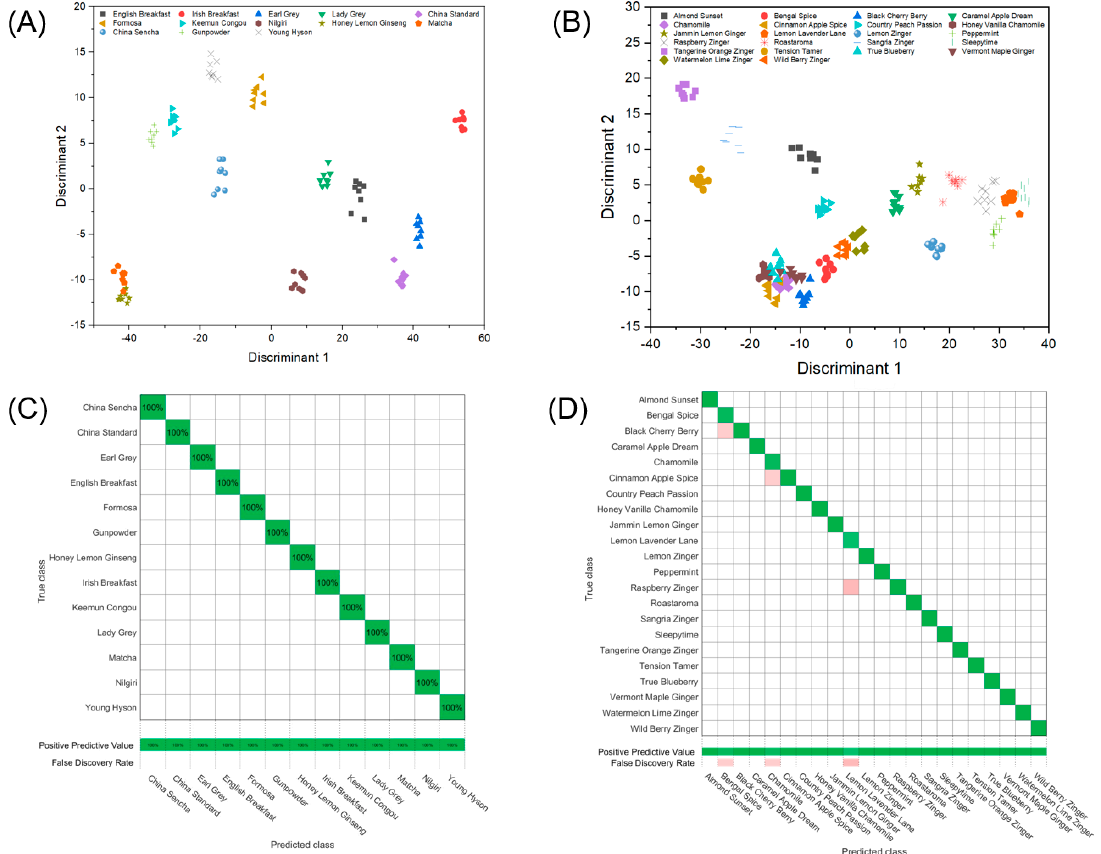
Figure 5. LDA plots of ( A ) eight black tea analytes and five green tea analytes and ( B ) 22 herbal tea analytes on the same chip assembled with four types of functionalized gold nanoparticles (38 devices). Confusion matrix shows ( C ) 100% classification accuracy for black teas and green teas, and 97.7% for ( D ) herbal teas.